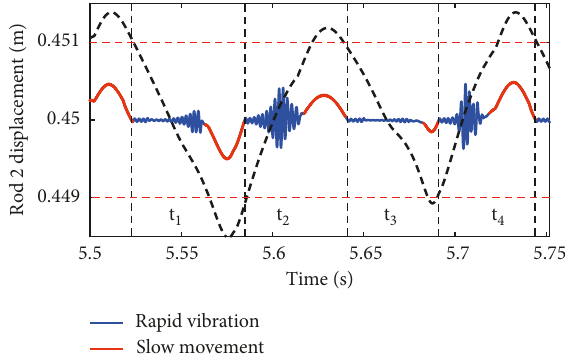
Figure 9: Displacement x 2 of rod 2 in the clearance model ( c � 0.5 mm, 5.5 s < t < 5.75